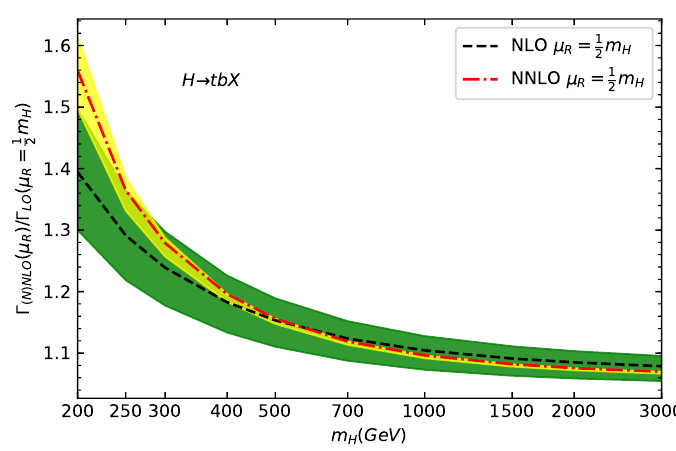
Figure 3. The NLO (dashed black line) and NNLO (dot-dashed red line) partial decay width of charged Higgs boson decaying into a top quark and jets for different charged Higgs boson masses. The green (yellow) band is bounded by the maximum and minimum of NLO (NNLO) partial width at three renormalization scales µ R = m H , 1 m H , 1 m H . All the results are normalized to the LO 2 4 partial width at µ R = 1 m H . 2